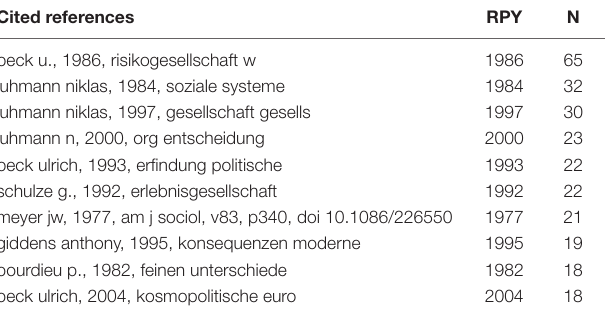
TaBle 4 | Ten most-cited publications in Soziale Welt (automatic disambiguation using crexplorer); February 14,